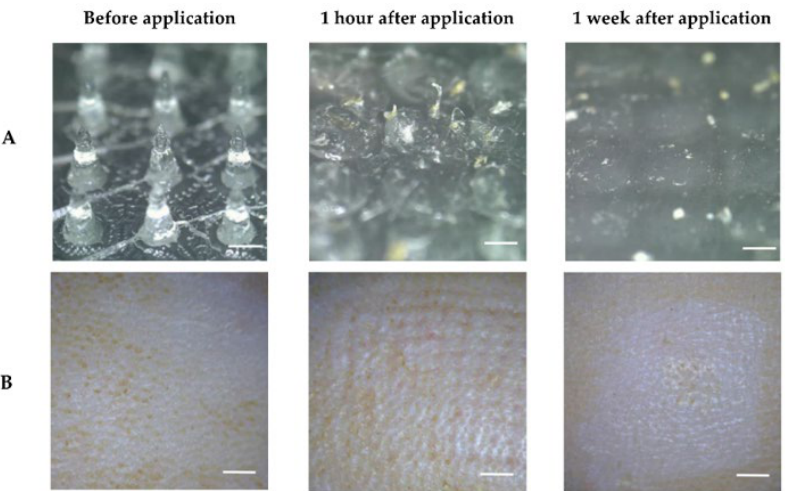
Figure 6. ( A ) In vivo dissolution of microneedles over time. Scale bar: 500 µm, and ( B ) in vitro skin irritation of donepezil-loaded hydrogel dissolving microneedles. Scale bar: 2 mm. Adapted with permission from [89], copyright © 2021 MDPI.